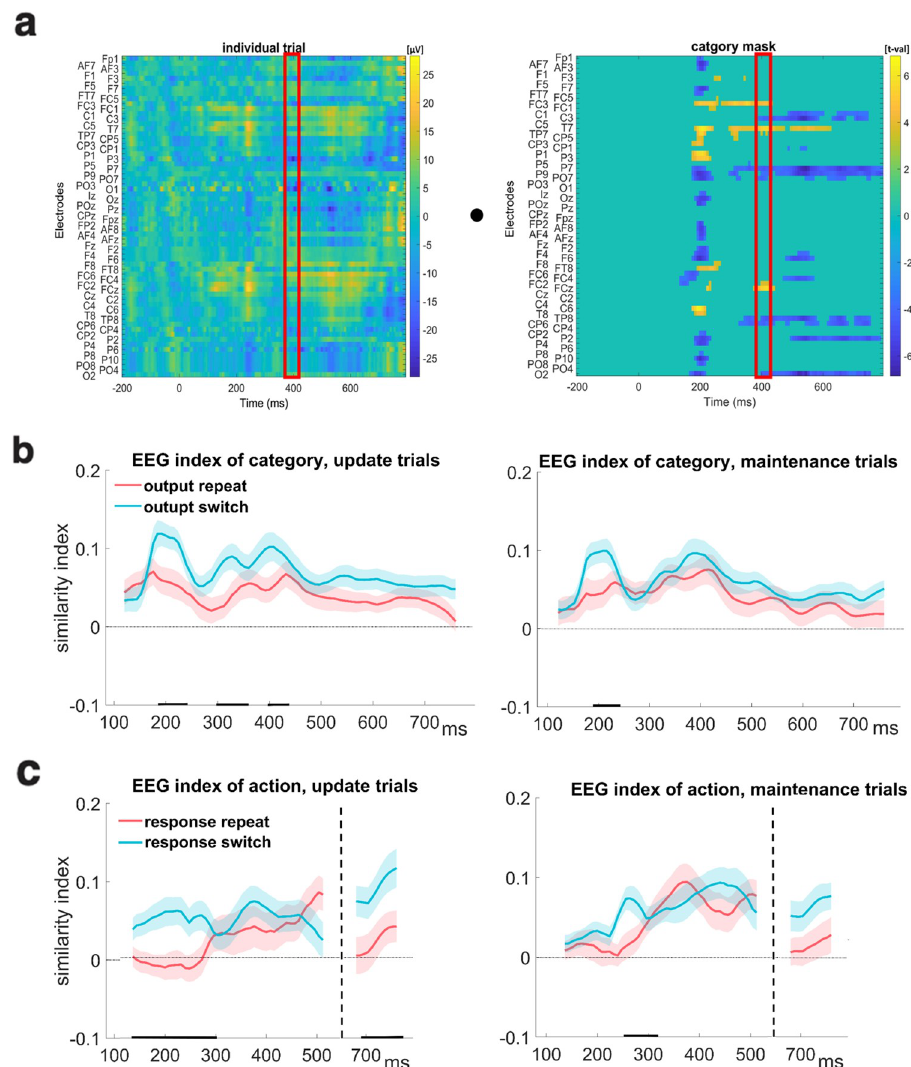
Fig 5. Temporal dynamics of neural prioritization by gating. (a) Trial-by-trial indexing of gated representations. Univariate patterns were identified for each representation of interest using GLM. Trial by trial similarity indices obtained by computing the dot-product between the 2D voltage-time map on individual trials with that of the mask for the relevant representation. As an example, the similarity computation with the category mask is shown. This similarity index is obtained over sliding window time bins (red rectangle). The result is a temporally evolving EEG index of similarity in time points for which the mask was significant (see methods for more detail). (b-c) The temporal dynamics of similarity indices to the relevant representations in updating (left) and maintenance (right) trials. (b) The neural similarity to the selected category enhanced following switches in the output gate. (c) The neural similarity to the selected action enhanced following switches in the response gate. Note that the GLM mask of action was significant in two time windows (in an early window between 100-500ms and in a later window 670-800ms) that are separated by the black dashed line (in between these periods the mask was not significant, and hence there is no similarity to plot). The shaded error bars represent standard error of the mean (SEM). The black markers on the x-axis reflect the time points where the similarity index differed between switch and repeat (see methods for more